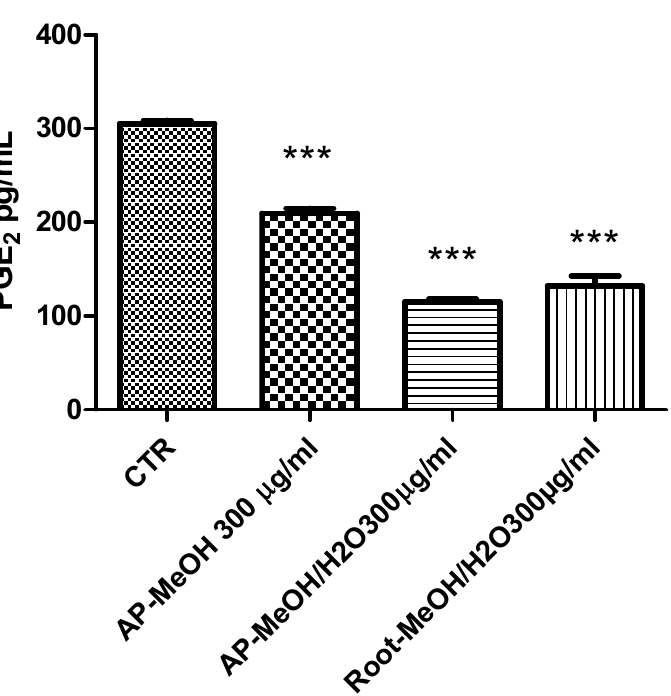
Figure 5. Inhibitory effects of PGE2 release induced by the methanol (MeOH) and methanol/water (MeOH/W) extracts of aerial parts (AP) and roots from Epilobium hirsutum (100–300 µg/mL). ANOVA, p < 0.0001, *** p < 0.001 vs. CTR (Control) group.